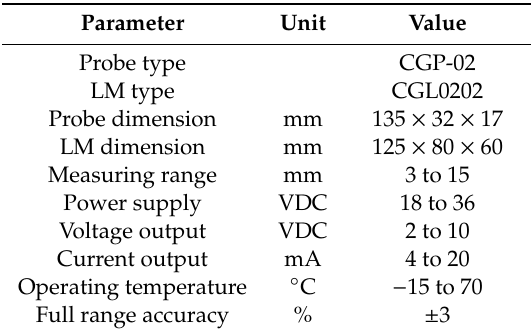
Figure 11. Testing environment for real time load angle measurement. Table 1. Technical specifications of the capacitive air gap sensor Veski CGS020210 used in the